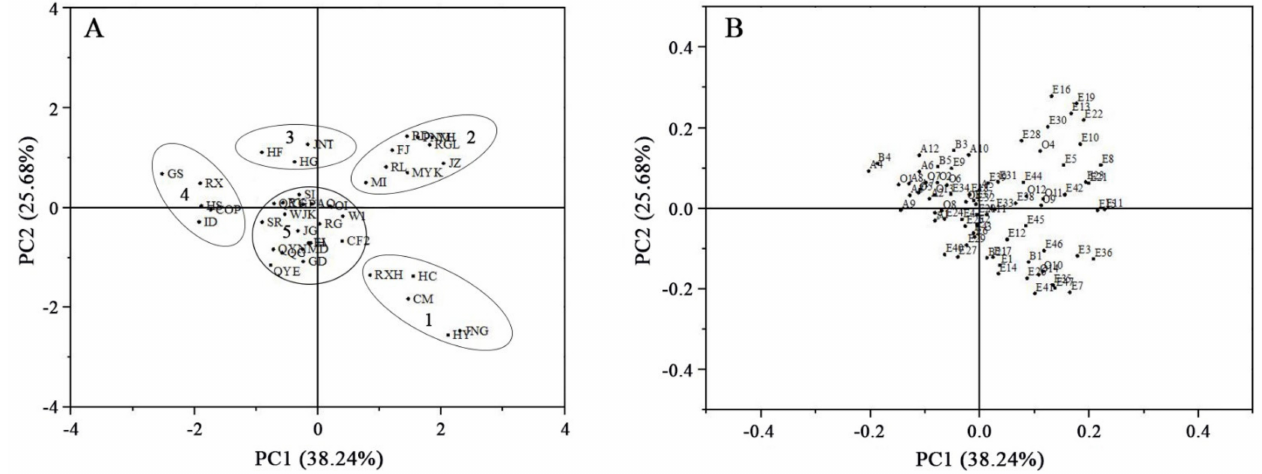
Figure 3. Principal component analysis (PCA) of 40 apple cultivars. ( A ) shows the PCA scores scatter plot. ( B ) shows a PCA loading plot. The codes in ( A , B ) correspond to codes in Tables 1 and 2,